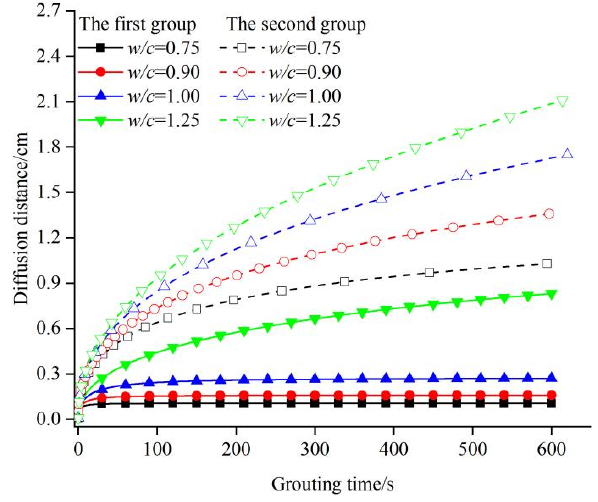
Figure 6. Schematic diagram of the diffusion radius with different groundwater pressures.